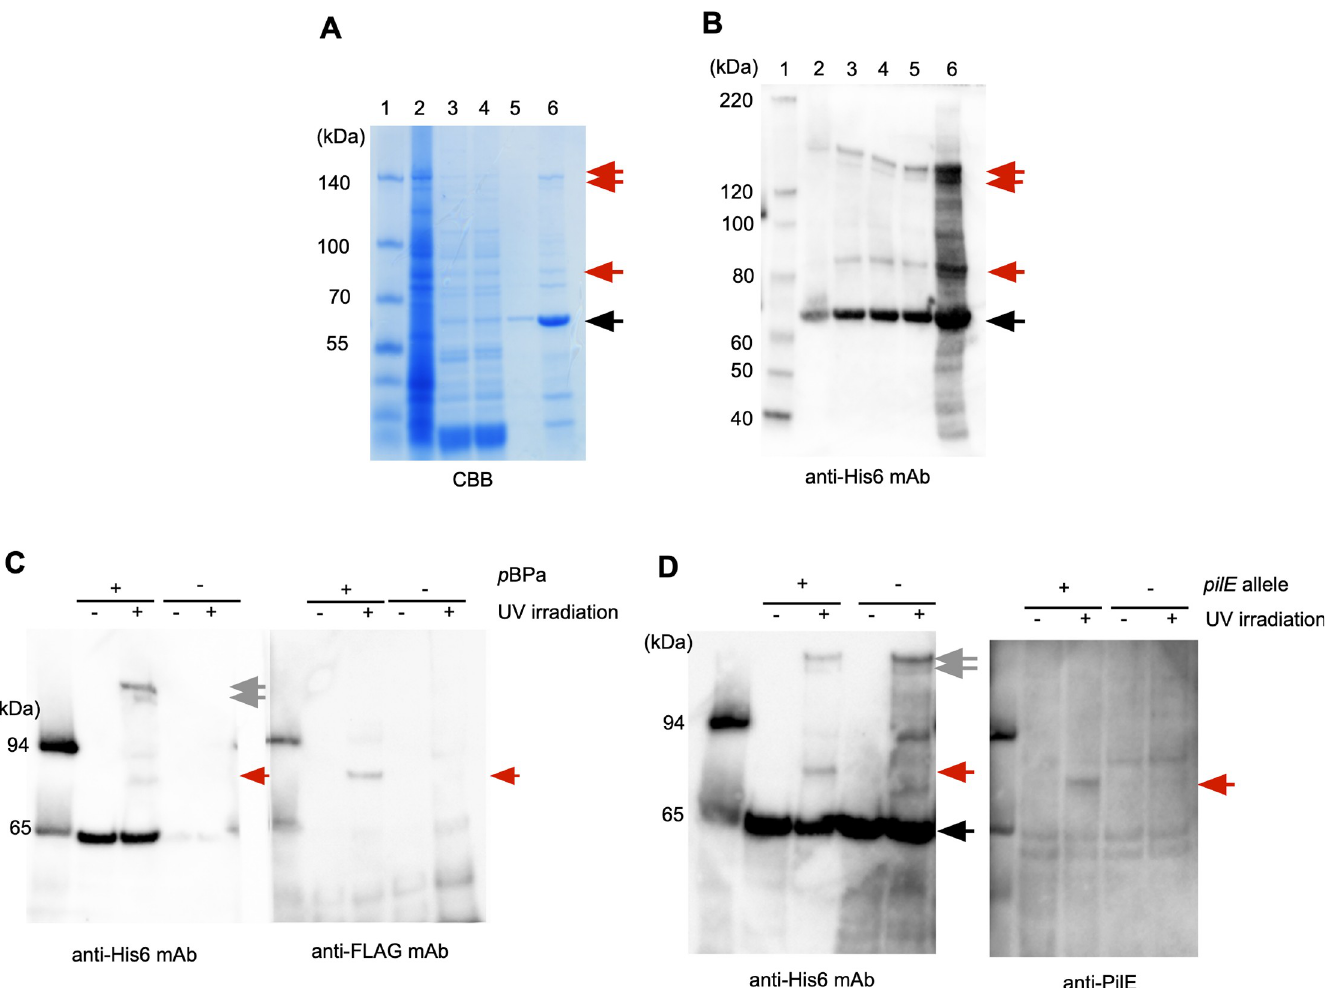
Fig 5. Purification and identification of an endogenous protein crosslinked to PamA K278( p BPa)-Strep 2 -His 6 . Proteins in each purification step were analyzed by 4–12% SDS-PAGE and staining with the CBB staining kit (A) and Western blotting with anti-His 6 mAb (B). Lane 1, molecular mass standards; lane 2, N . meningitidis crude soluble extract; lane 3, after the Ni-Sepharose column; lane 4, after dialysis with IP Lysis buffer; lane 5, after the Strep-Tactin Sepharose column; lane 6, after concentration with VIVASPIN TURBO 15. Black and red arrows indicate K278( p BPa)-Strep 2 -His 6 and the unidentified endogenous proteins crosslinked to PamA K278 ( p BPa)-Strep 2 -His 6 , respectively. (C) The PilE-FLAG protein was crosslinked to PamA K278( p BPa) in N . meningitidis . The black arrow shows the full-length PamA K278amb protein expressed by pyrrolysine-based amber suppression with p BPa, and the gray arrow indicates the homotrimer (See text) in N . meningitidis . The red arrow shows the complex of PilE-FLAG crosslinked to PamA K278( p BPa)-Strep 2 -His 6 in N . meningitidis . +/- indicates the presence or absence of p BPa, and irradiation or no irradiation with UV light, respectively. (D) The crosslinked band was reacted with anti-PilE rabbit serum. Black and gray arrows show PamA K278( p BPa)-Strep 2 - His 6 and the putative homotrimer complex of PamA K278( p BPa), respectively, in N . meningitidis . The red arrow shows the complex of PilE crosslinked with PamA K278( p BPa)-Strep 2 -His 6 in N . meningitidis . +/- indicates the presence or absence of the pilE gene, and irradiation or no irradiation with UV light,